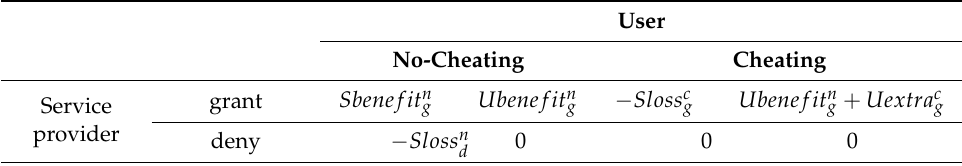
Table 2. Payment matrix between user and service